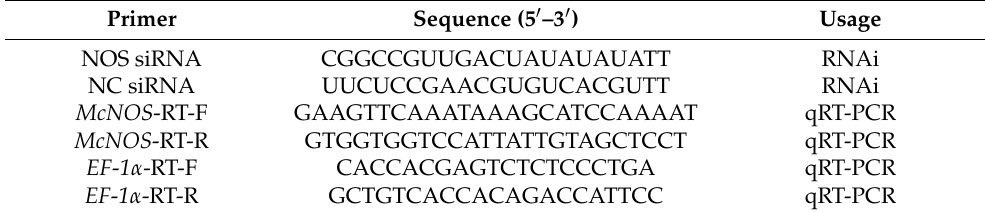
Table 1. Primer sequences used for M. coruscus NOS mRNA expression